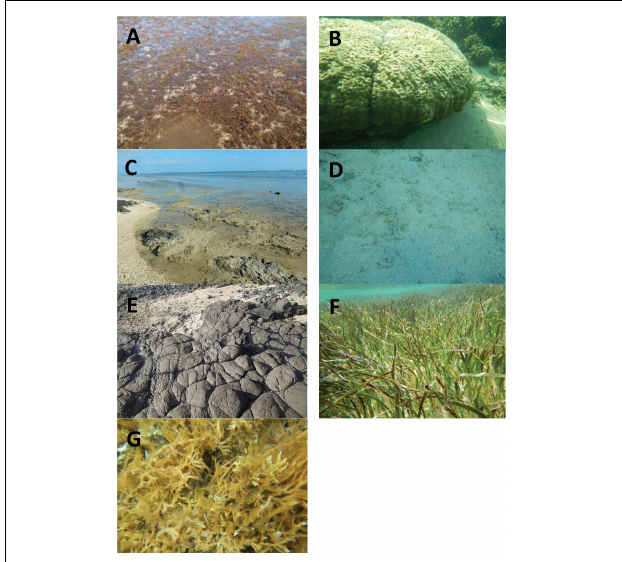
FIGURE 2 | Seven benthic class types based on data collection at Komave. The letters represent each class type: (A) brown algae, (B) coral, (C) bare, (D) sand and gravel, (E) volcanic rocks, (F) sea grass, (G)